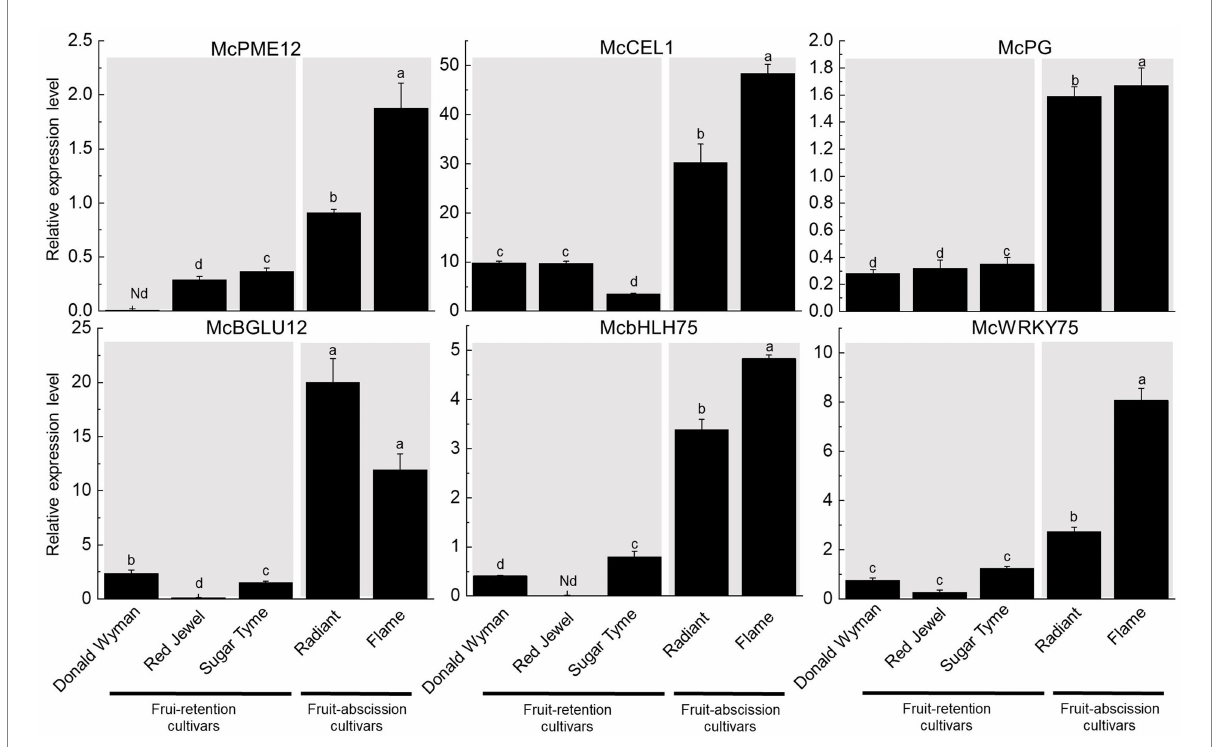
FIGURE 6 Six genes were selected for quantitative real-time PCR (qRT-PCR). The data were normalized by using McActin as an internal reference. Data were represented as mean ± SD for three biological